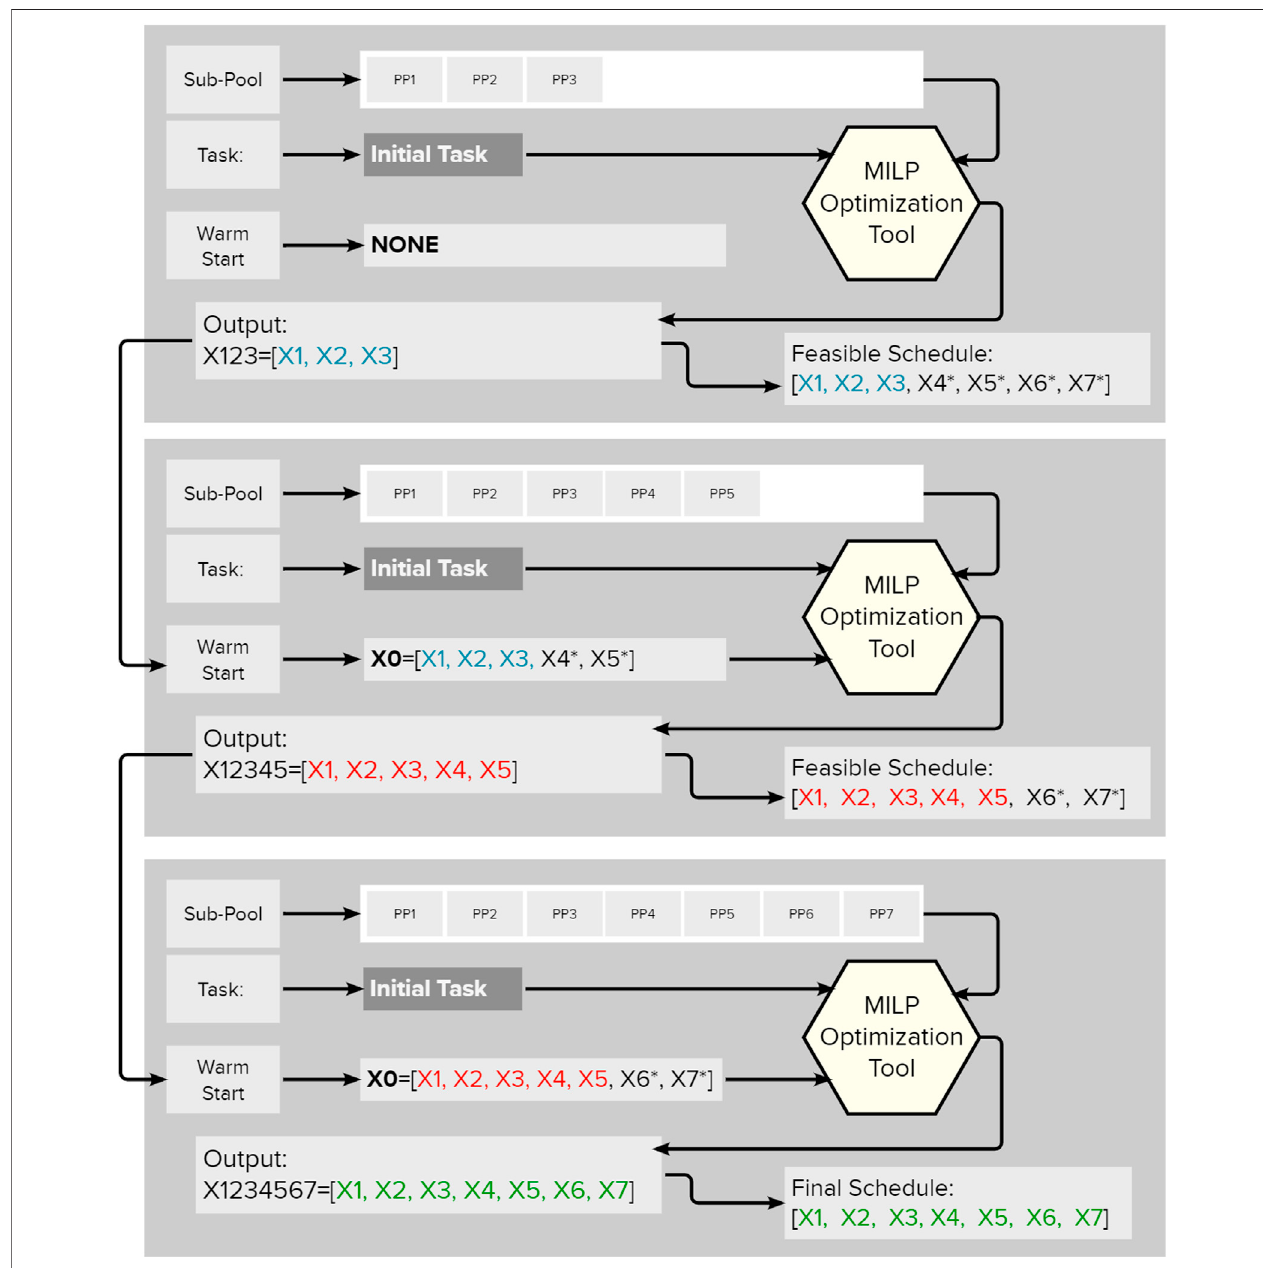
FIGURE 1 | The visualization of the Gradual Increase